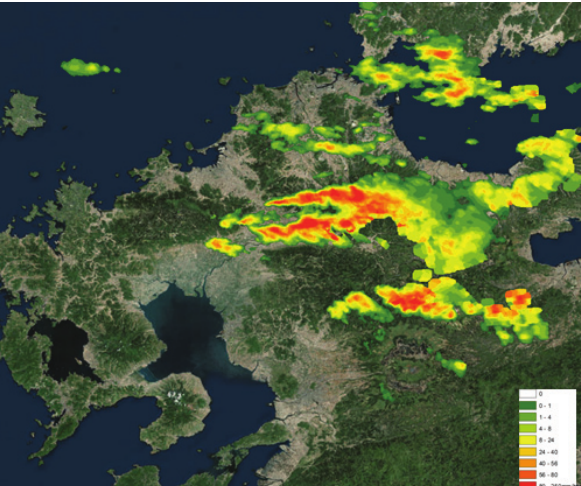
Figure 12. Result of inputting rainfall information of the X-band MP radar into GIS (2017.7.5 17:00).